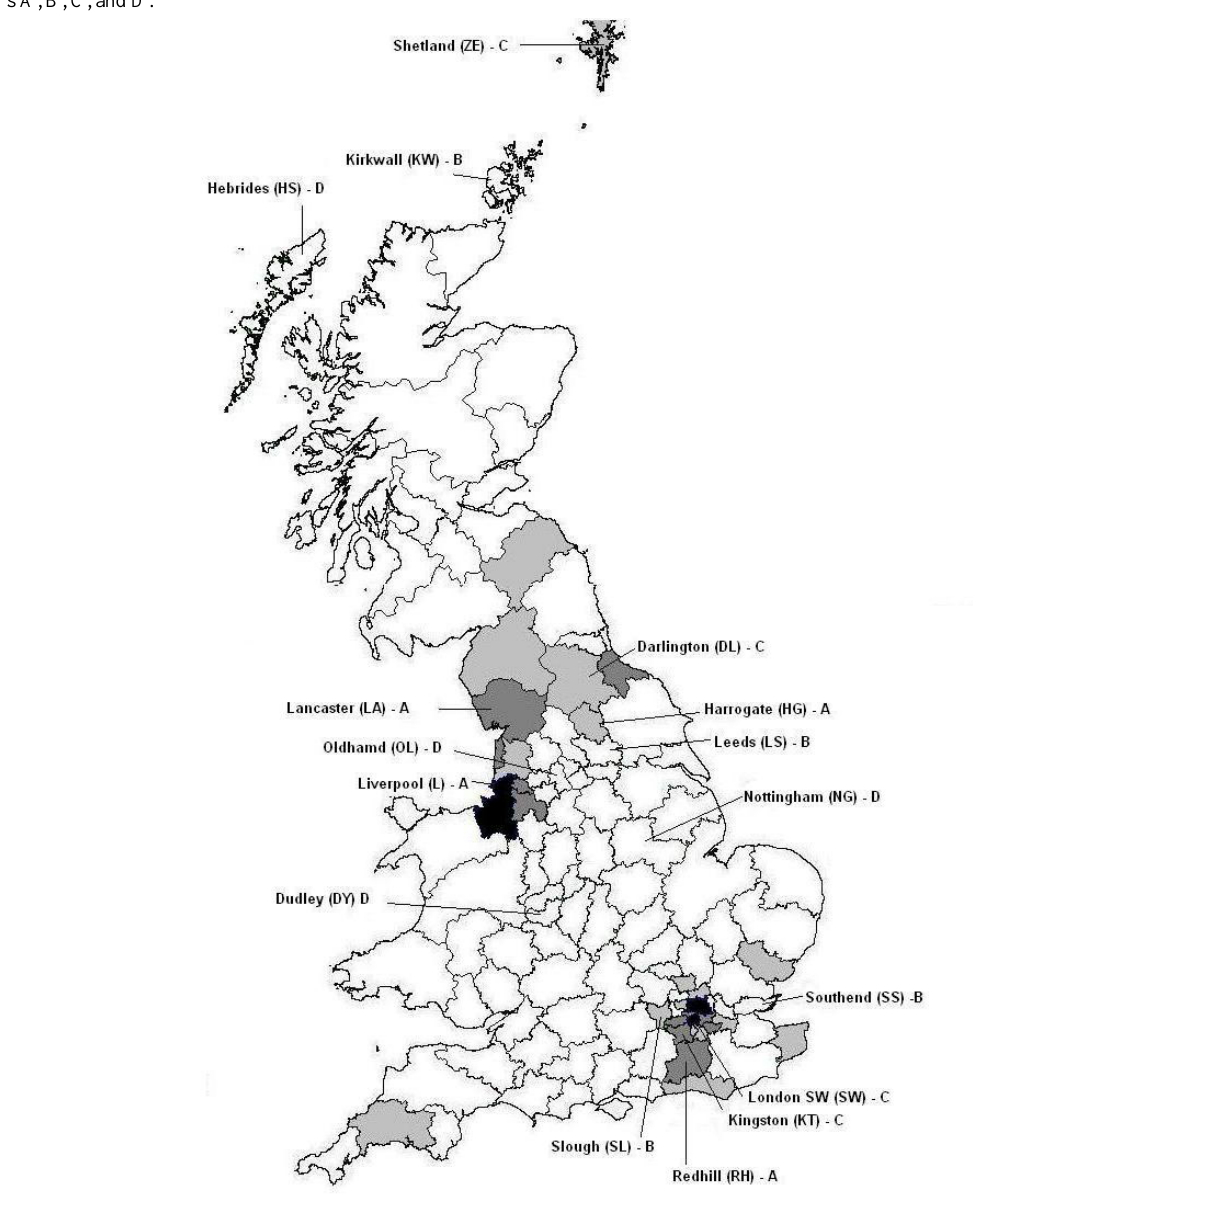
Figure 2. Postcode areas (as stated by participants) showing number of participants (out of 2236) expressed as a rate per million in four groups: darkest, 120+; dark gray, 80 to less than 120; light gray, 40 to less than 80; white, less than 40. Map shows the 16 postcode areas in the study, four in each of arms A, B, C, and D.